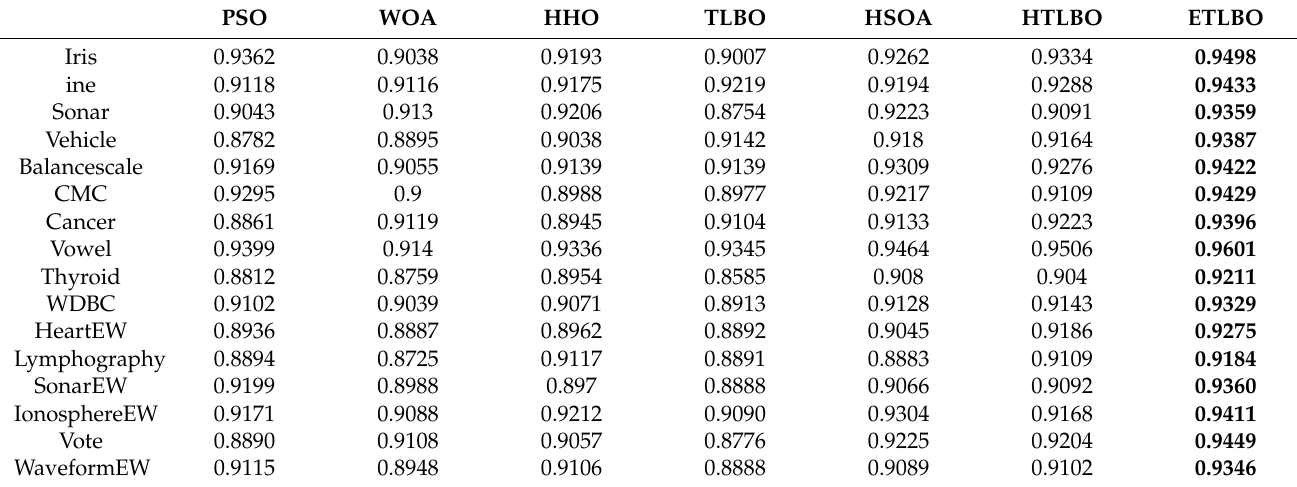
Table 7. The f-score of compared